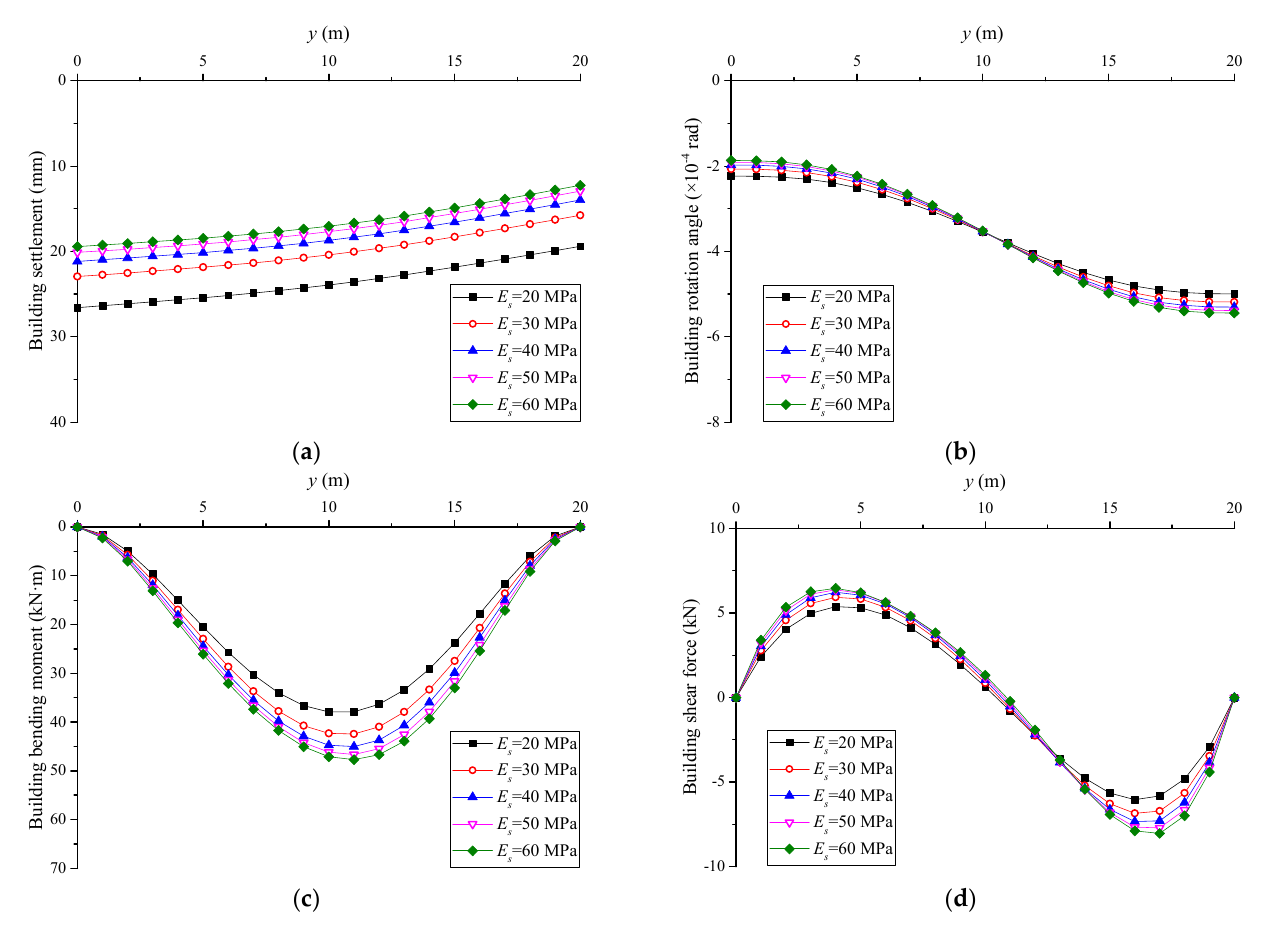
Figure 11. Building response with different soil elastic moduli: ( a ) settlement; ( b ) rotation angle; ( c ) bending moment; ( d ) shear force.